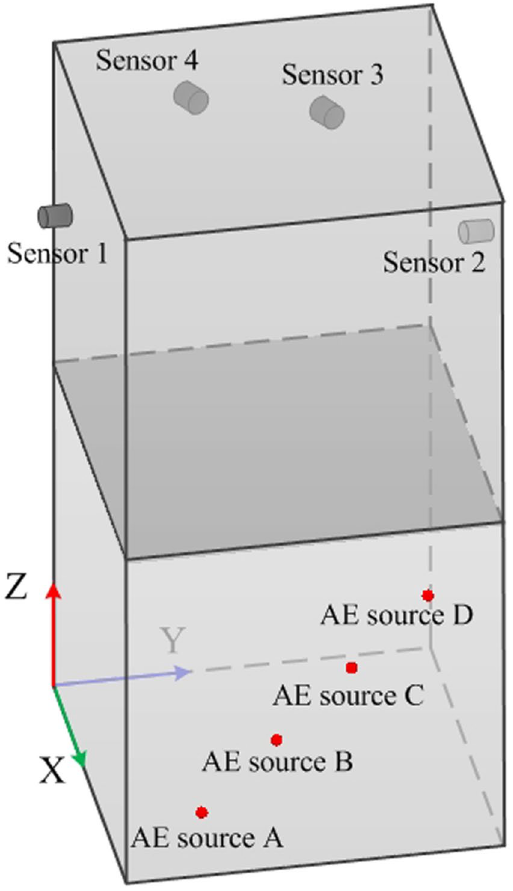
Figure 9. The positions of the sensors and the pencil-lead-break positions of the